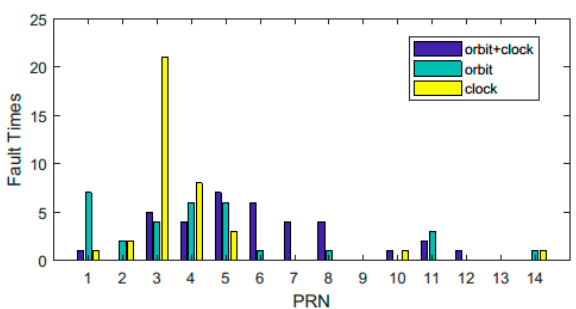
Figure 9. Anomaly times of different satellites corresponding to unhealthy states that lasted for only one hour. Different colors refer to different types of faults.